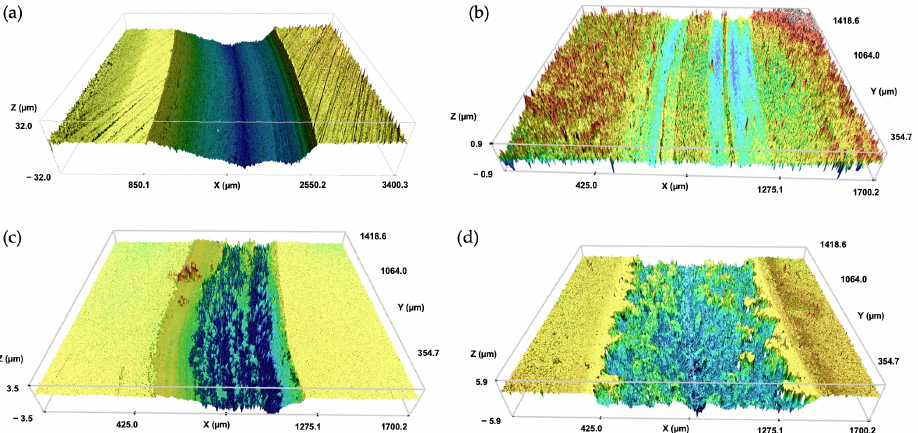
Figure 10. Images of the wear tracks obtained by confocal microscopy for uncoated WC-TiC-Co samples sliding in dry conditions ( a ) and in NaCl solution ( c ), and AlCrSiN coated samples in dry conditions ( b ) and in NaCl solution ( d